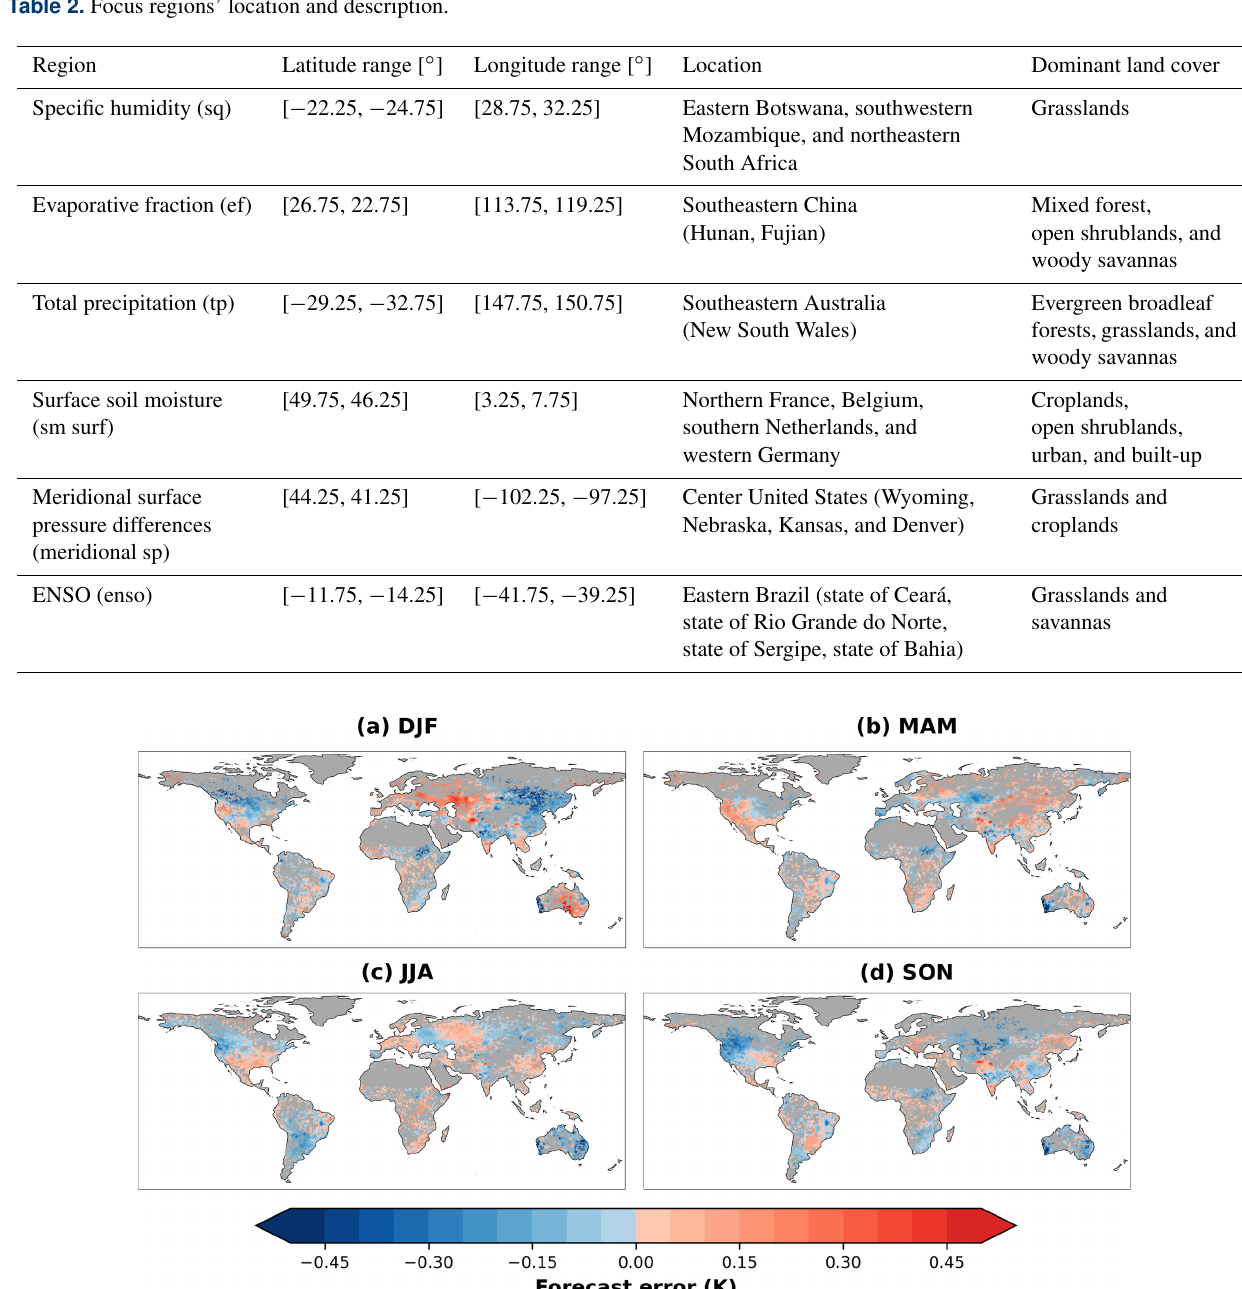
Table 2. Focus regions’ location and description.